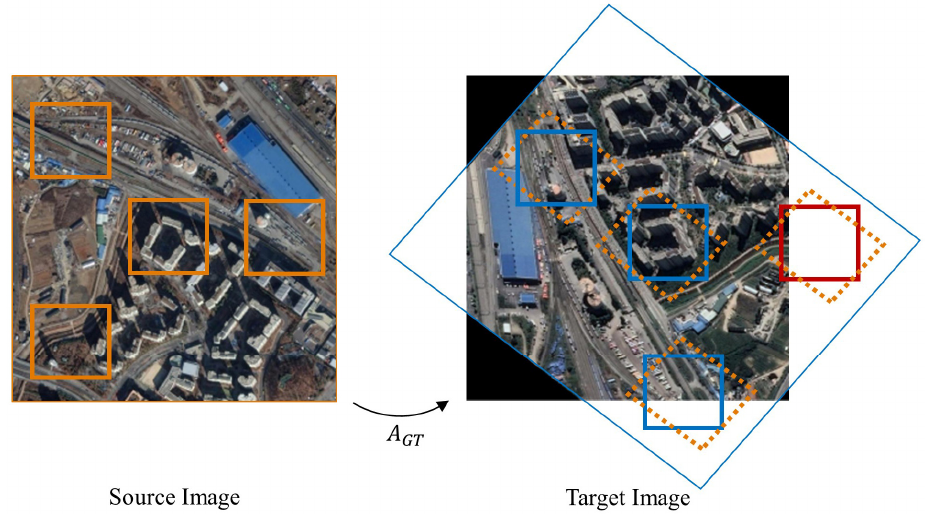
Figure 8. Example of generating training samples. The orange boxes indicate the cropped sub-images from the source image, the orange dotted boxes indicate the location where the corresponding sub- images lie after transformation, the blue boxes indicate the cropped target sub-images, and the red boxes indicate the sub-images out of